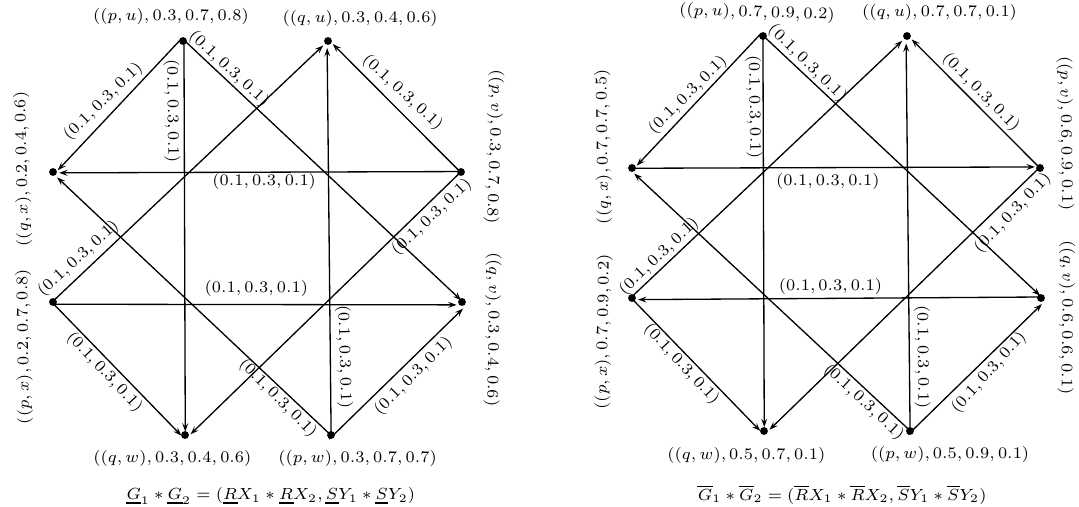
G 2 ). G , G 1 1 ∗ 2 ∗ G 2 ). G , G 1 G 2 ). Figure 10. Neutrosophic rough digraph G = ( G G , G 1 1 ∗ 2 ) ∗ 1 ∗ 2 1 ∗ G 2 , G 1 ∗ G 2 ∗